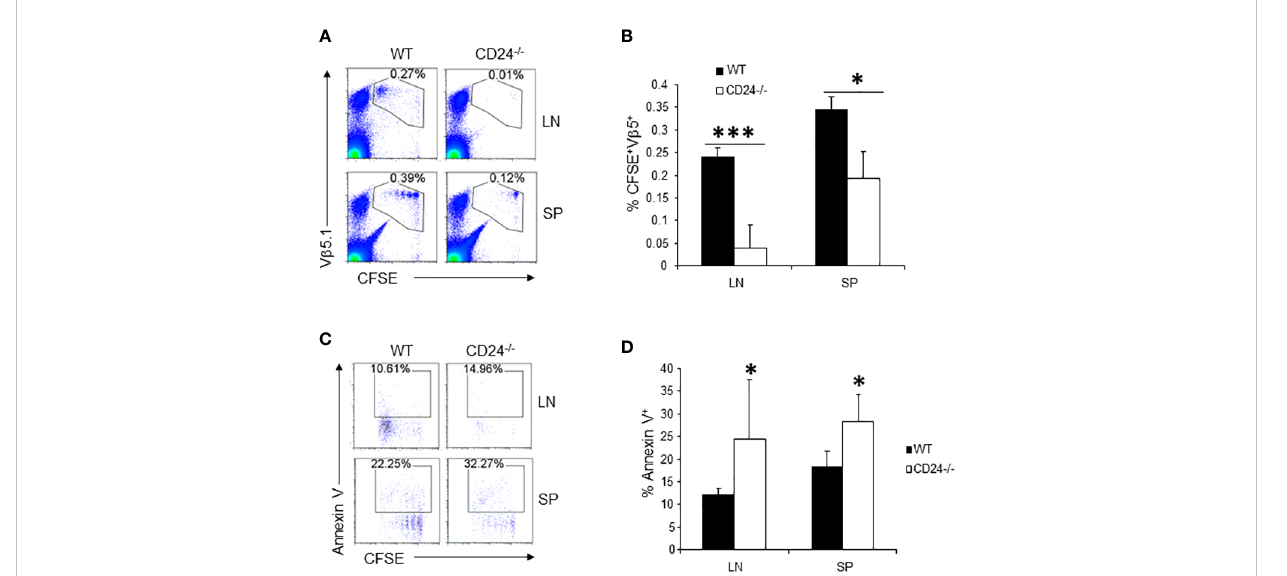
uniformly expressed CD24 (Figure S2). CFSE-labeled 2D2 T cells were injected into CD24 -/- and DC CD24 CD24 -/- mice followed by immunization with MOG35-55/CFA. As demonstrated in Figure 7A and quanti fi ed in Figure 7B, restoration of CD24 expression on DC resulted in the restoration of T cell proliferation and accumulation in the draining lymph